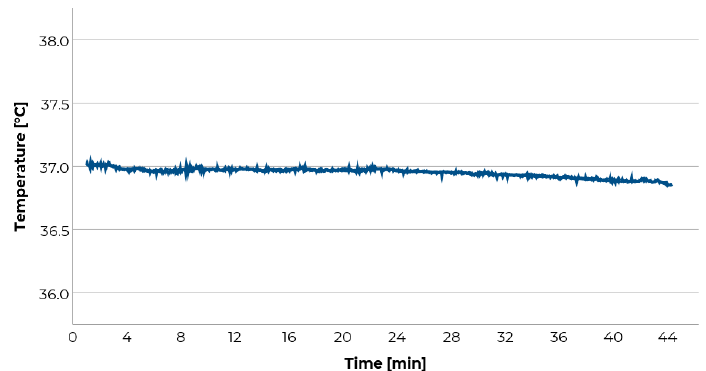
Figure 4. Exemplary raw temperature data of a participant during a 44-min drive as passenger on a German Autobahn. In contrast to other physiological data, temperature is hardly affected by artifacts (see Figures 5 and 6).